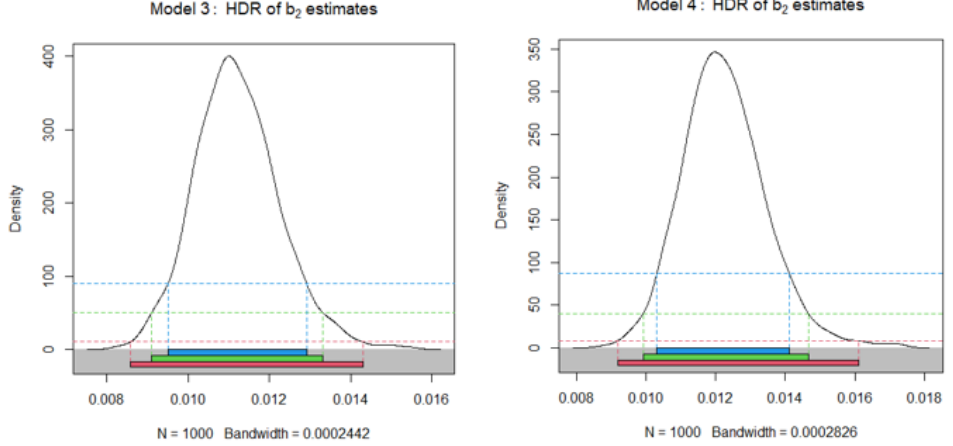
Figure 2. HDR of b 2 estimates. Model 1 to Model 4 (data from 1959 to 1989). Figure 2. HDR of 𝑏 2 estimates. Model 1 to Model 4 (data from 1959 to 1989). Figure 2. HDR of 𝑏 2 estimates. Model 1 to Model 4 (data from 1959 to 1989).